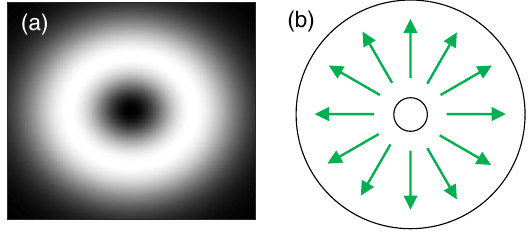
FIG. 2. (a) The transverse intensity distribution and (b) radial polarization of the doughnut mode TEM 01 (cid:1)